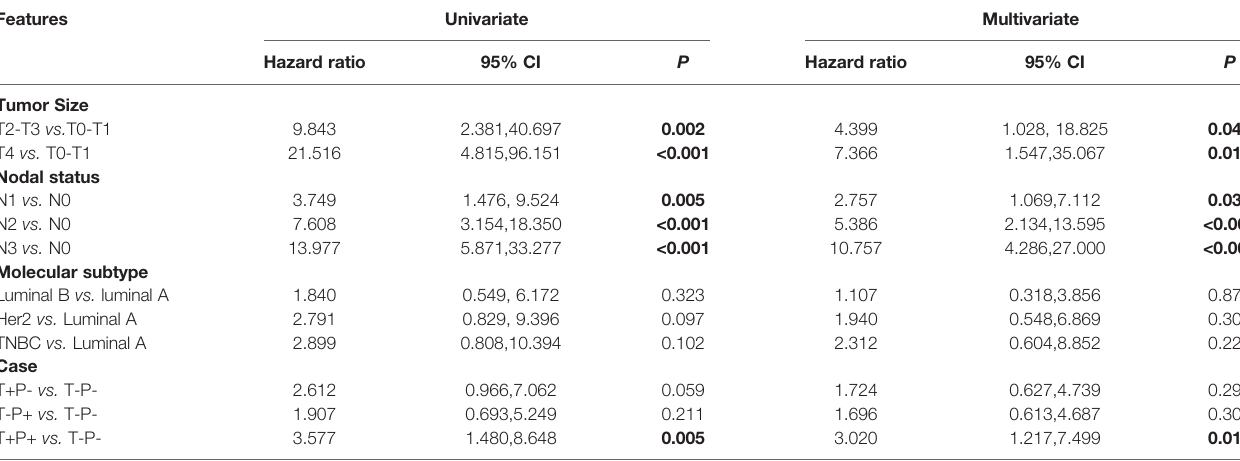
TABLE 5 | Disease-free survival of patients diagnosed with breast cancer.